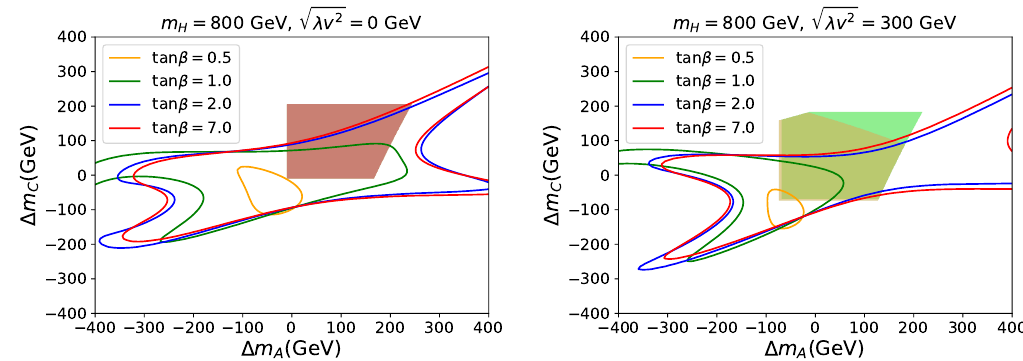
Figure 10 . Allowed region from three-parameter (cid:12)tting results at 95% C.L. in the (cid:1) m A (cid:11) ) = 0 ; m H = 800 GeV. The left panel is for p (cid:21)v 2 = 0, plane with varying tan (cid:12) under cos( (cid:12) (cid:0) while the right one for p (cid:21)v 2 = 300 GeV. tan (cid:12) is chosen to be 0.5 (orange), 1 (green), 2 (blue), 7 (red). Also shown are the allowed regions by theoretical constraints, which are indicated with shadows of the same color